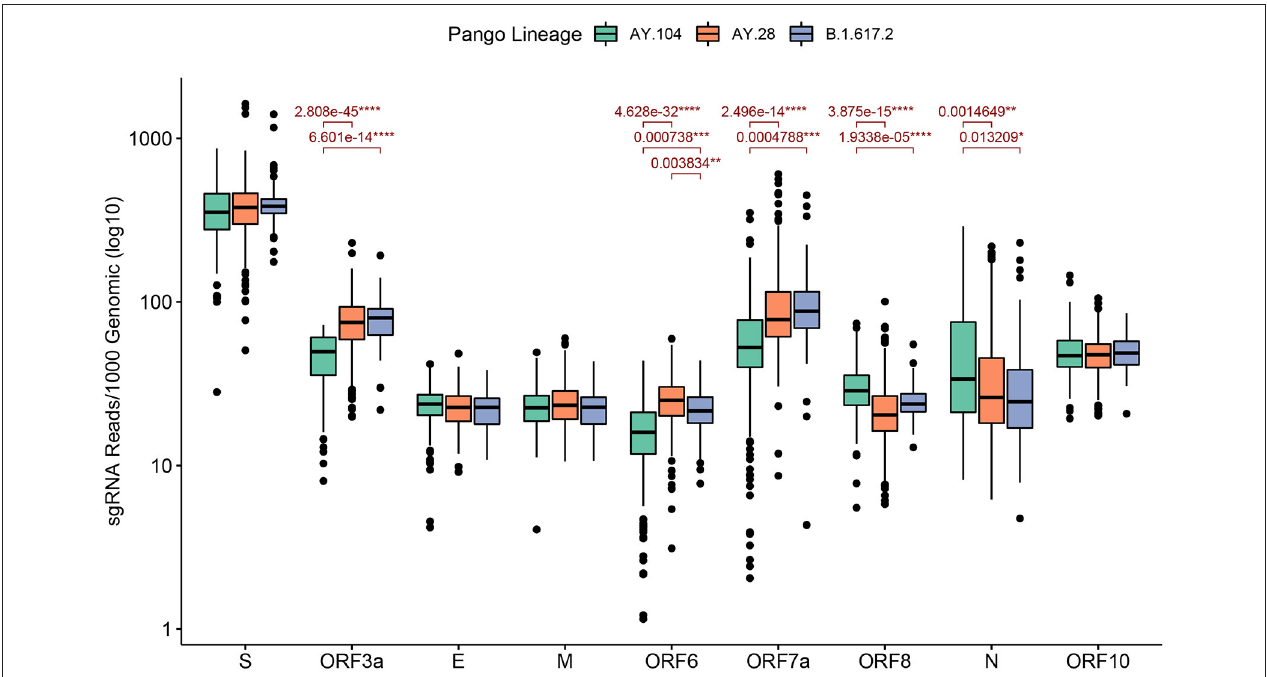
FIGURE 4 | Sub-genomic RNA expression of the delta sub-lineages sequenced in Sri Lanka. Sub-genomic RNA (sgRNA) expression levels of AY.28 ( n = 335), AY.104 ( n = 217) and B.1.617.2 ( n = 68) viruses sequenced in Sri Lanka. SgRNA reads containing the leader sequence are normalized to per 1000 genomic reads for each open reading frame (ORF) of SARS-CoV-2 using Periscope. Significant differences of mean expression levels are indicated with a p value calculated using an unpaired Wilcoxon test adjusting p -values of multiple comparisons with the Holm method (**** < 0.0001, *** < 0.001, ** < 0.01, * <